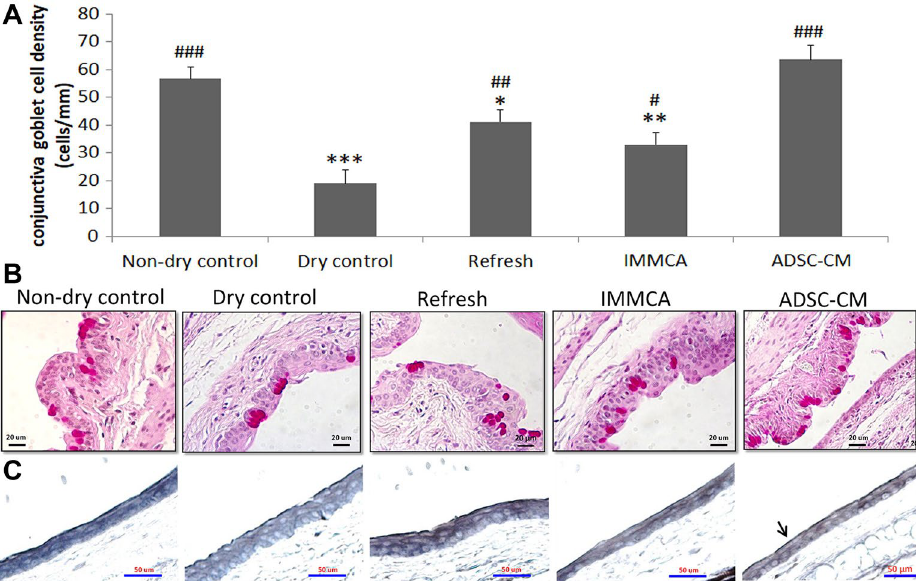
Figure 2. Conjunctival goblet cell density and MUC16 expression of the BALB/c mice in the controlled- environment chamber (CEC)-induced dry eye model. (A,B) Periodic acid–Schiff staining showed that conjunctival goblet cells were reduced in the CEC-induced dry eye. Refresh Plus lubricant eye drops and Iscove’s modified Dulbecco’s medium supplemented with mesenchymal stem cells culture adjuvant (IMMCA) partially reversed the reduction, while ADSC-CM best preserved the density of goblet cells. Data were presented as means ± SD. *p < 0.05, **p < 0.01, ***p < 0.001 compared with non-dry control. #p < 0.05, ##p < 0.01, ###p < 0.001 compared with dry control group. (N = 5). (C) Immunohistochemical analysis of MUC16 showed that conjunctival MUC16 expression was continuous in the non-dry group (99% continuity) but disrupted in the dry group (89% continuity), Refresh Plus group (90% continuity), and IMMCA group (90% continuity). Topical application of ADSC-CM in the CEC-dry eye mice helped keep the continuous expression of MUC16 (97%